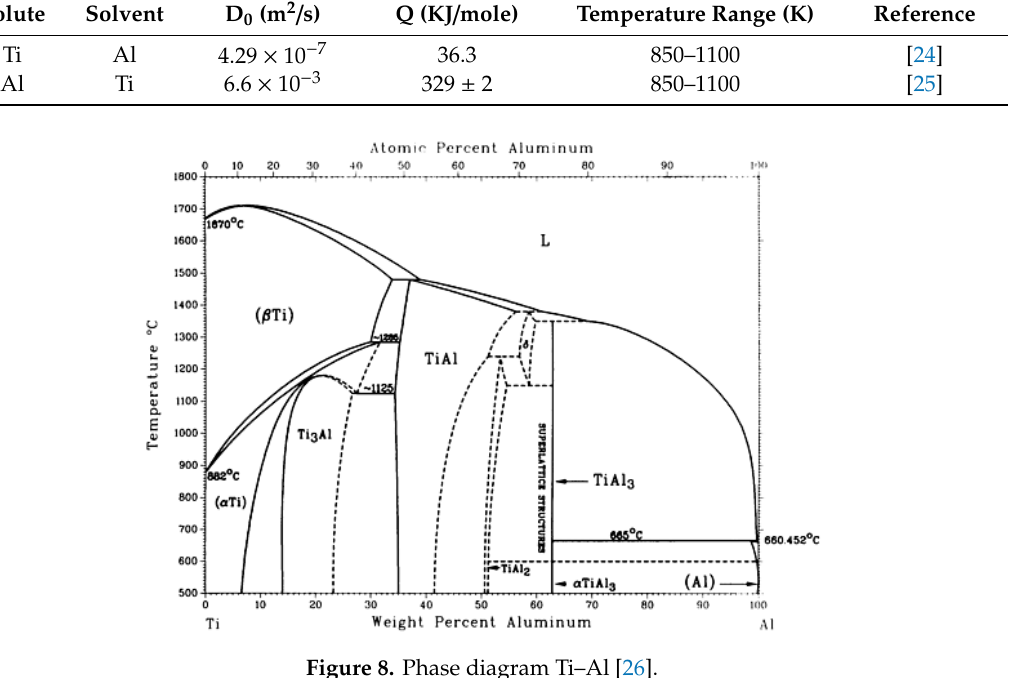
Figure 9. Engineering stress–strain curves of the prepared composites and the matrix. Table 3. Tensile properties of the prepared composites in as-casting. Materials